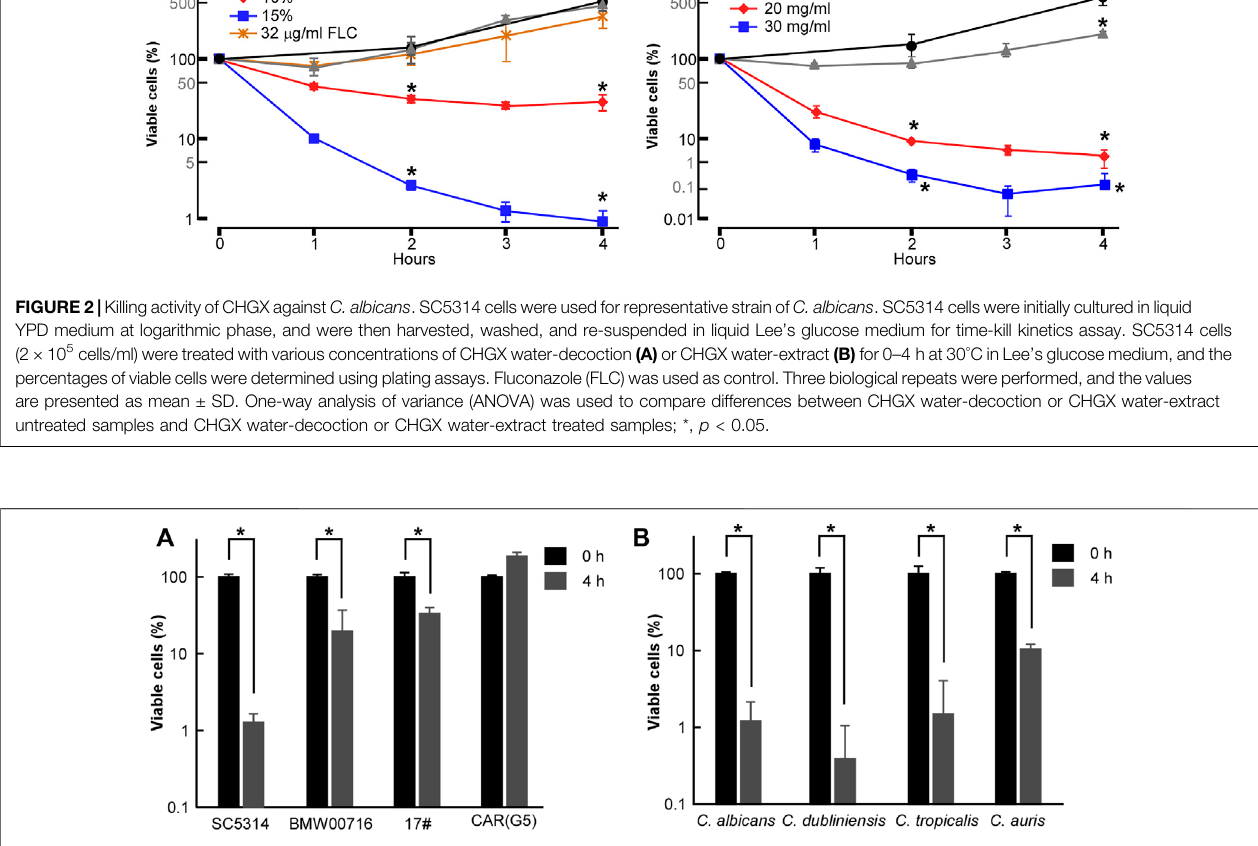
FIGURE3| AntifungaleffectsofCHGXwater-extractonazole-resistantstrainsof C.albicans ,andotherclinicalfungalspecies.Cellsofazole-resistantstrains (A) or clinical strains (B) of C. albicans (P37005), C. dubliniensis (D173), C. tropicalis (JX1002), C. auris (BJCA001) were initially cultured in liquid YPD medium at logarithmic phase,andwerethenharvested,washed,andre-suspendedinliquidLee ’ sglucosemediumforatime-killkineticsassay.Fungalcells(2×10 5 cells/ml)weretreatedwith 20 mg/ml GHGX water-extract for 0 h and 4 h at 30 ° C in Lee ’ s glucose medium, and the percentage of viable cells was determined using plating assays. Three biologicalrepeats wereperformed, and the values are presented asmean ± SD. One-way analysis ofvariance (ANOVA) was employed tocompare differences between 0 and 4 h as indicated; *, p <